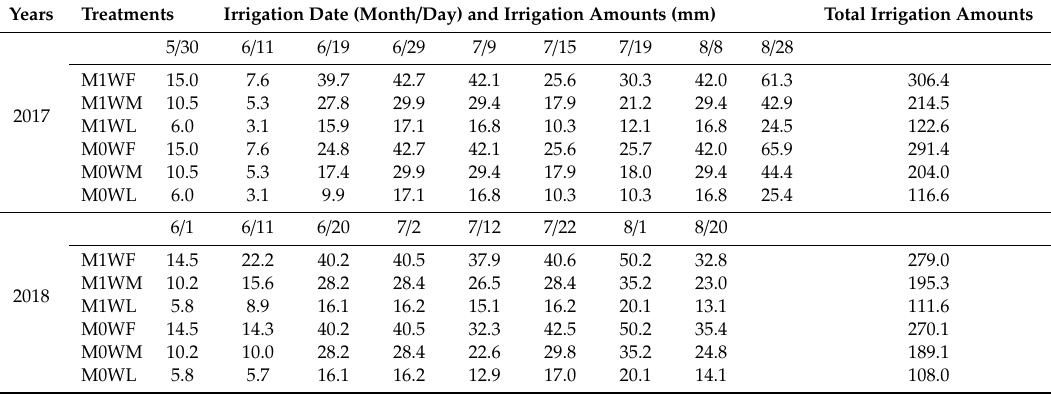
Table 1. Irrigation amounts (mm) under di ff erent treatments during 2017 and 2018. Years Treatments Irrigation Date (Month / Day) and Irrigation Amounts (mm)